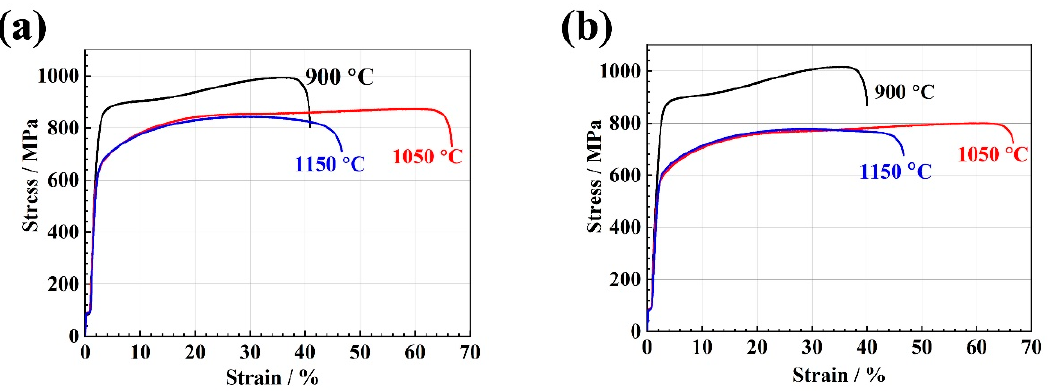
Figure 2. Stress–strain curves of Cr19 series DSS after solution treatment at 900, 1050, and 1150 °C for 5 min, ( a ) Cr19, and ( b ) Cr19 + W DSS. Table 2. Tensile test results of Cr19 series DSS after solution treatment at 900, 1050, and 1150 °C for 5 min.